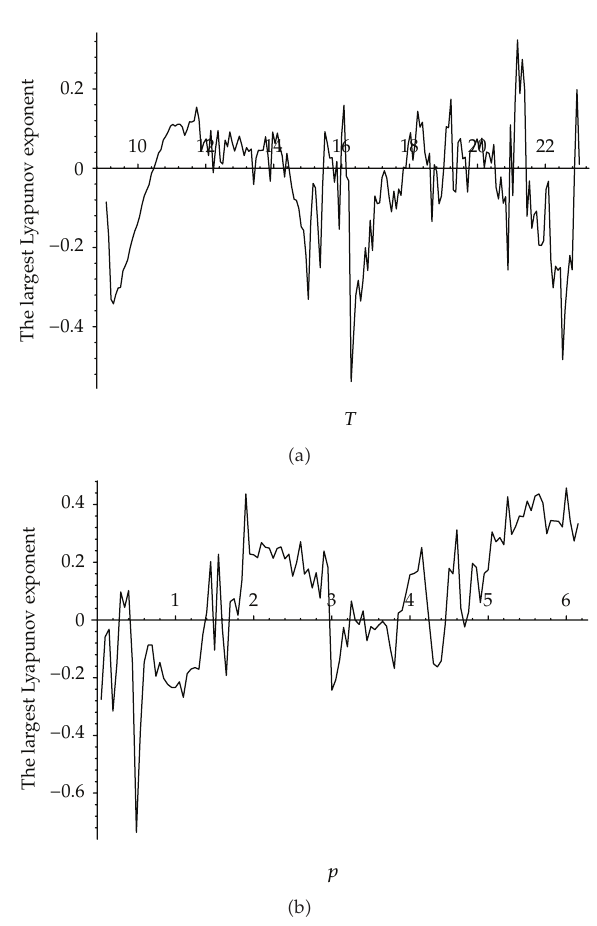
Figure 6: (cid:2) a (cid:3) The largest Lyapunov exponent (cid:2) T ranging from 9 to 23 (cid:3) for system (cid:2) 1.1 (cid:3) ; (cid:2) b (cid:3) the largest Lyapunov exponent (cid:2) p ranging from 0 to 6.2 (cid:3) for system (cid:2) 1.1 (cid:3)